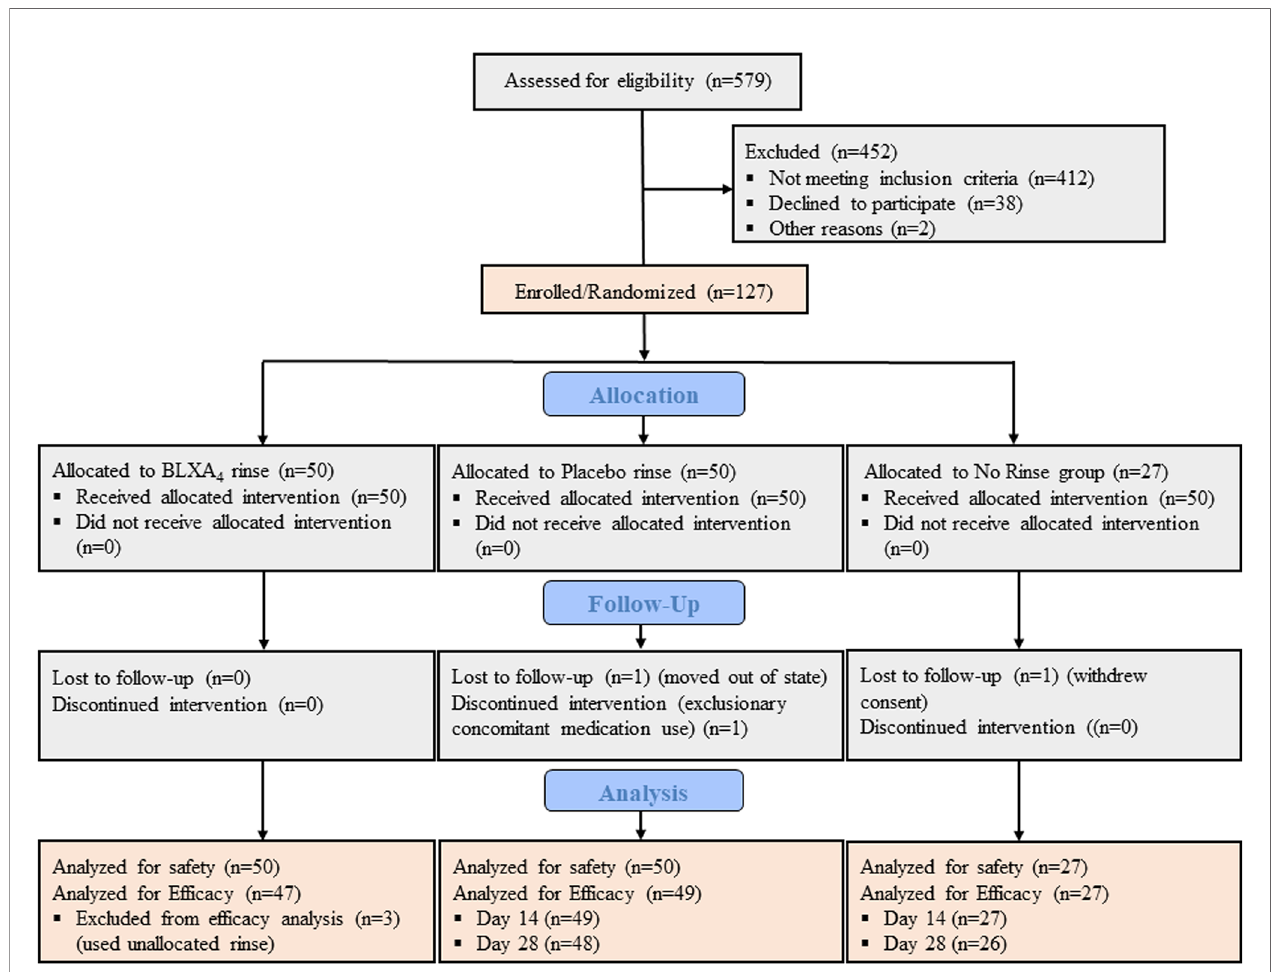
FIGURE 1 | CONSORT diagram. CONSORT subject fl ow diagram shows the number of subjects screened, enrolled/randomized, and included in the primary safety and secondary ef fi cacy analyses. Out of 579 patients screened, 127 individuals were found eligible, agreed to participate, and enrolled in the study. Fifty participants were randomized to BLXA 4 rinse, 50 to placebo rinse and 27 participants to no rinse control group. The primary endpoint safety analysis included all subjects treated with at least one dose of BLXA4 or placebo or those who completed at least one follow up visit after baseline. The secondary endpoint ef fi cacy analysis included those subjects who completed at least one follow up visit (starting at Day 14) for ef fi cacy measures (PD, CAL, BOP, PI). Two subjects dropped out before the necessary Day 14 visit completion, thus replaced per protocol. In BLXA 4 group, 3 subjects used unallocated rinse up to 3, 4 and 7 days respectively, thus excluded from ef fi cacy analysis. 1 subject in placebo and 1 subject in no-rinse groups did not complete Day 28 visit (lost-to-follow up and withdrew consent, respectively) and excluded from ef fi cacy analysis for that time